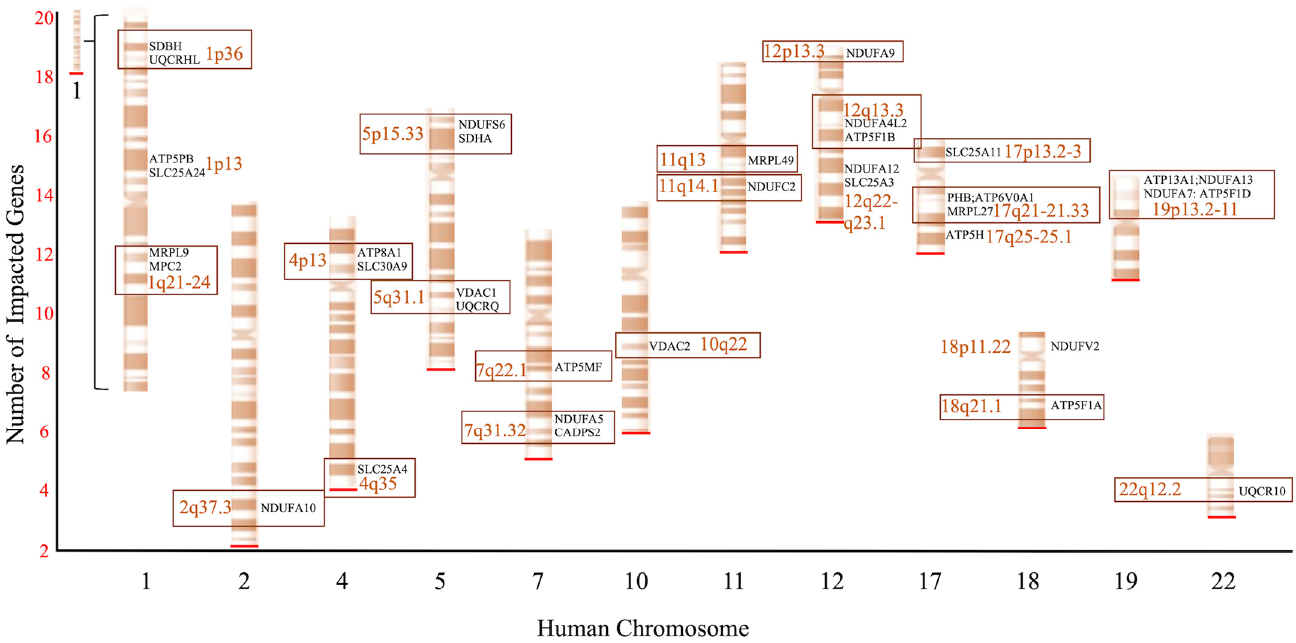
Figure 6. Genomic analysis of mitochondrial protein impacted by A β 42 . Genome enrichment analysis (GEA) was used to examine the number and location of genes that encode mitochondrial components of the A β 42 proteome. The red line indicates the total number of impacted genes/chromosome. Boxed are chromosomal regions of copy number variation that correlate with human disease. Chromosome 1, which contains 18 impacted genes, has been adjusted for size.